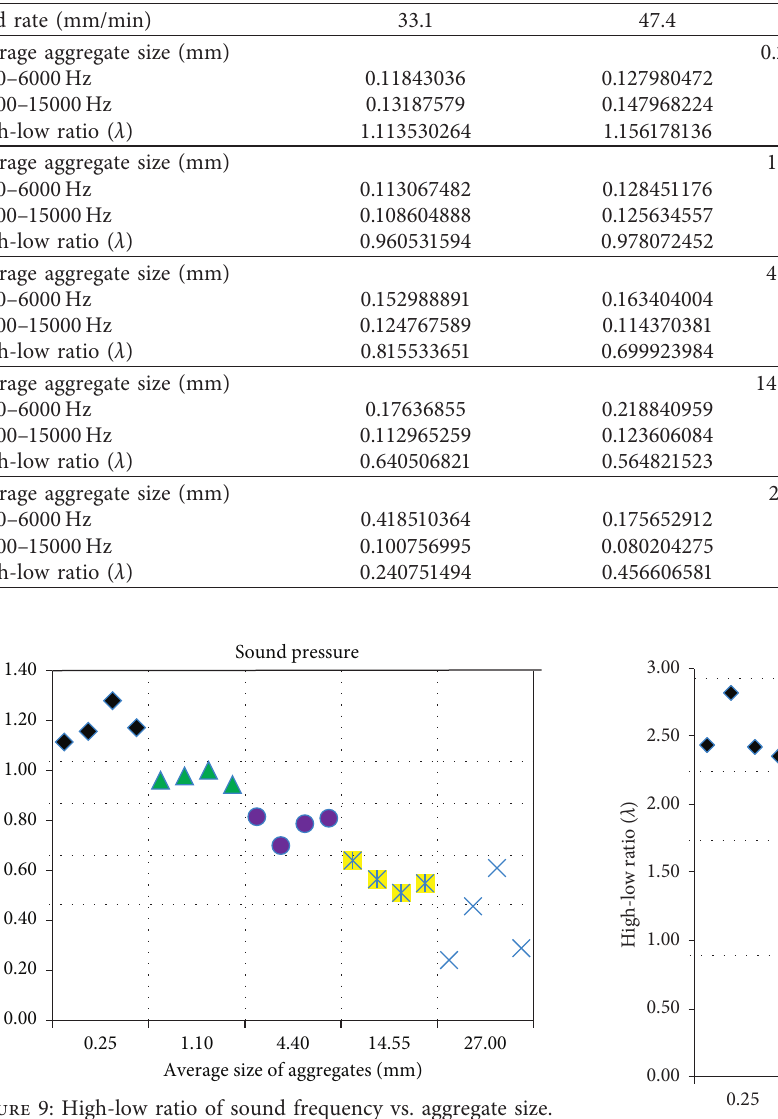
Table 4: High-low ratio of frequency ( λ ) for concrete samples with different aggregate sizes.